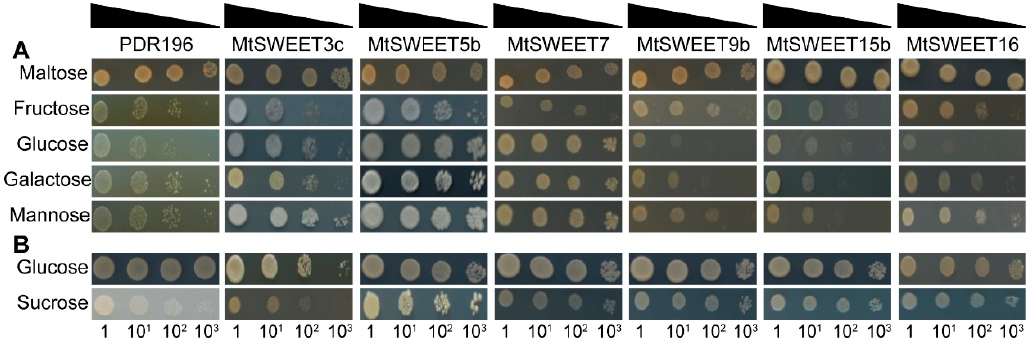
Figure 8. Substrate specificity analysis of six selected MtSWEET proteins in yeast mutant strains EBY.VW4000 ( A ) and SUSY7/ura3 ( B ). Cells were serially 10-fold diluted (10-, 100- and 1000-fold) and spotted on solid SD media supplemented with 2% concentration of different sugar substrates. Maltose and glucose were the sole carbon sources for the positive controls of EBY.VW4000 and SUSY7/ura3 cells, respectively.